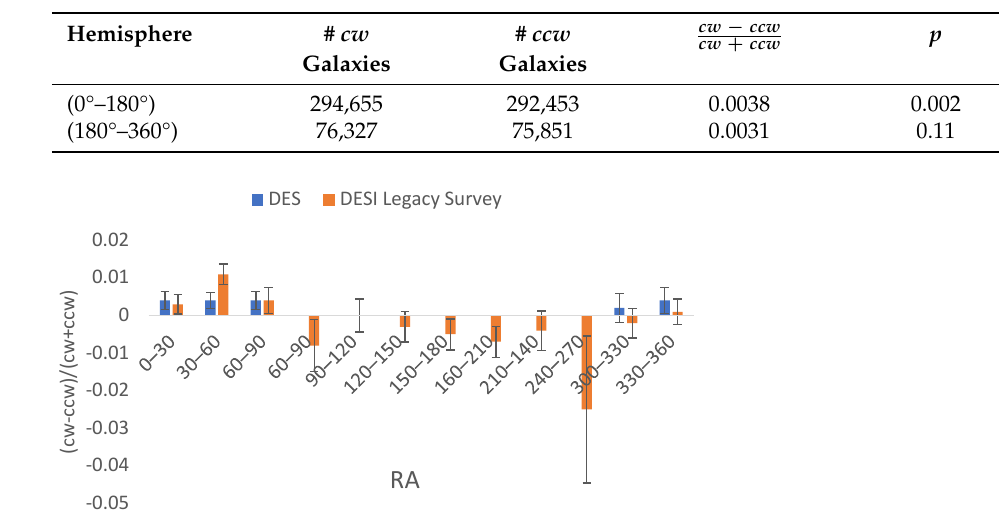
Table 6. Number of clockwise and counterclockwise galaxies in opposite hemispheres in DES.